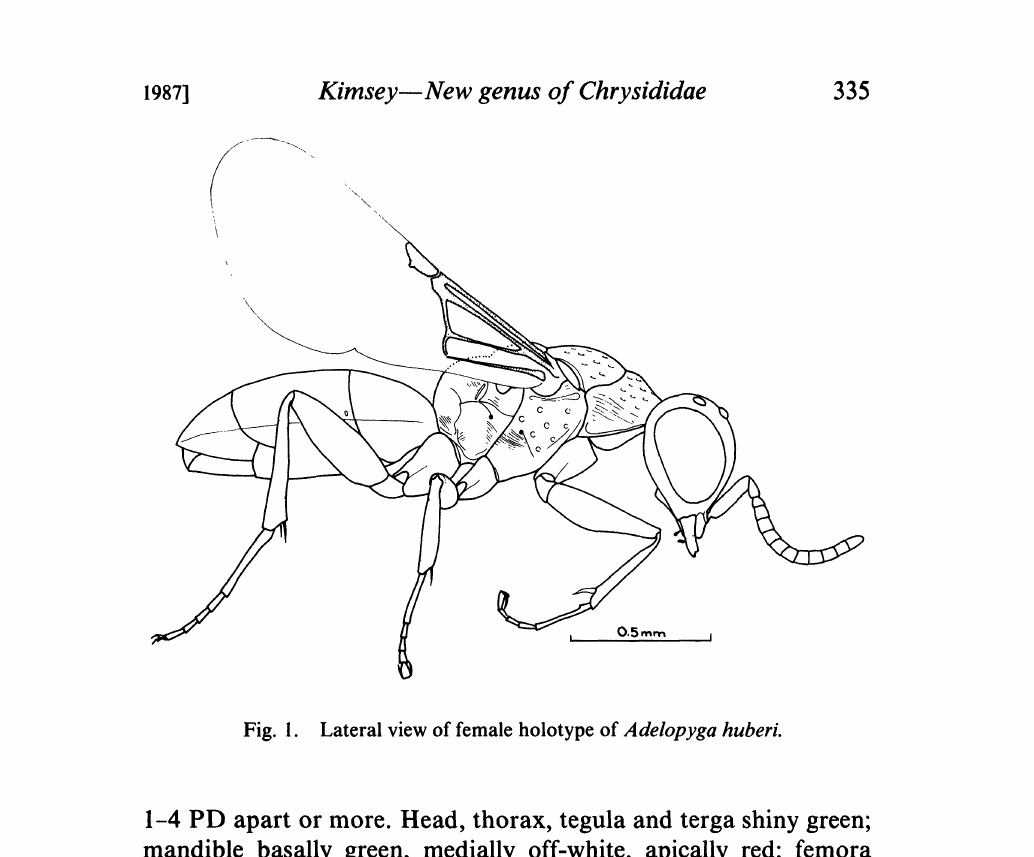
Fig. I. Lateral view of female holotype of Adelopyga